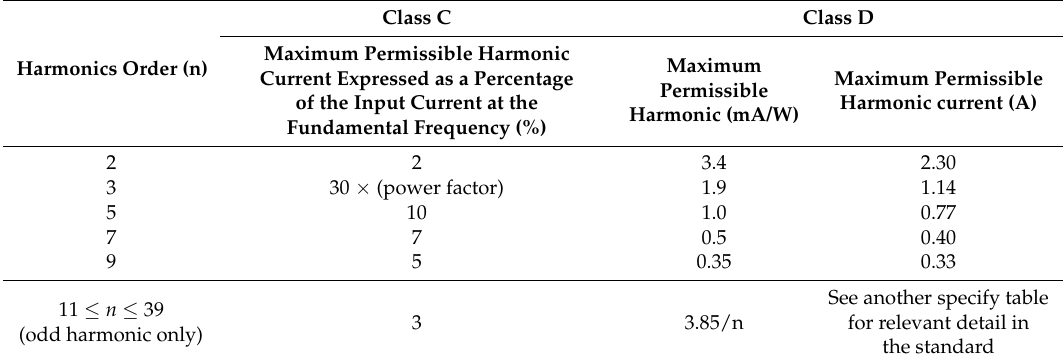
Table 1. Limit of harmonic current of lighting equipment (class C and D equipment)